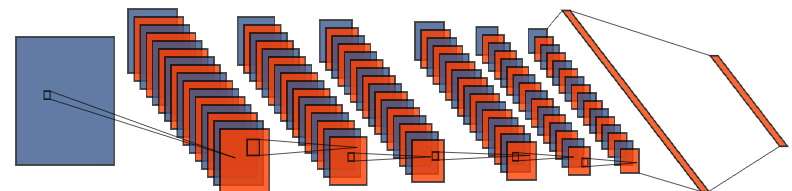
Figure 3. Construction of the generative model. Table 1. The parameter information for the generative model.